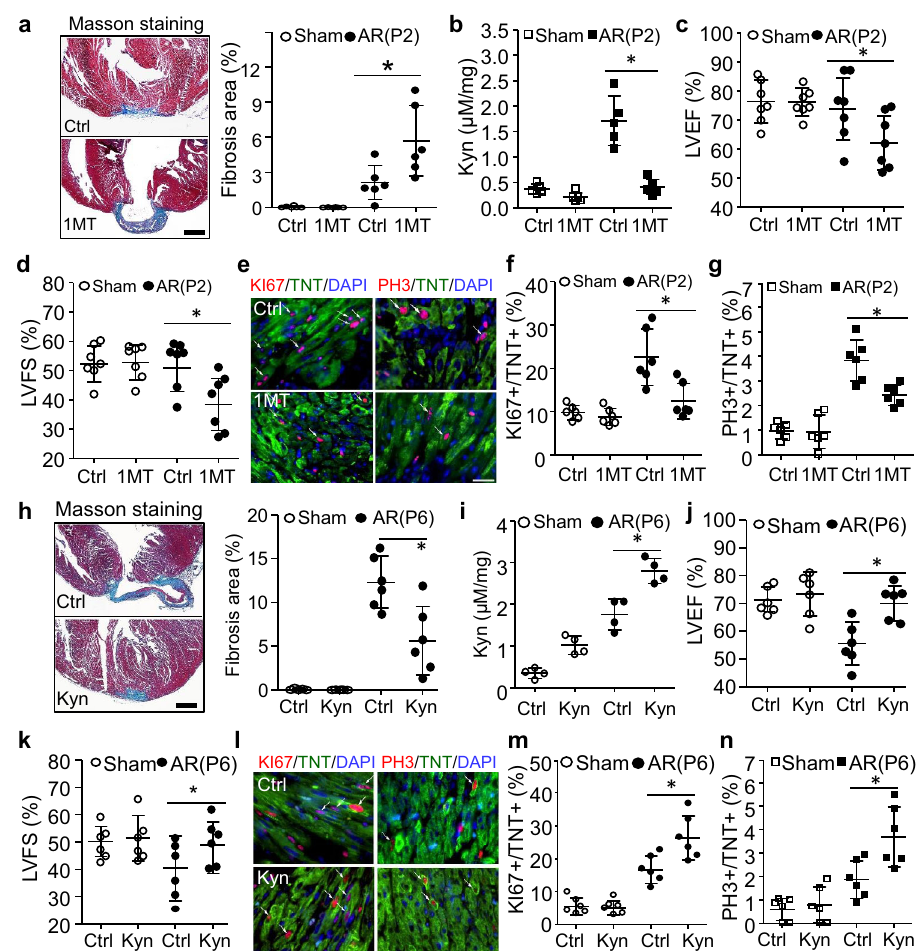
Fig. 2 | The effects of Kyn on neonatal heart regeneration. a – g Wild-type mice were intraperitoneally injected with IDO1 inhibitor (1-methyl tryptophan, 1MT, 100mg/kg)orPBS(Control,Ctrl)everyotherdayfromP1uptoP28andunderwent heart AR surgery at P2. Cardiac fi brosis, function, and Kyn concentration were analyzed at P28. a Masson staining was used for detection and quantitation of fi brosisarea( n =6/group,* P =0.0074). b CardiacKynconcentrationwasmeasured by HPLC ( n =5/group, * P <0.0001). c , d Left ventricular ejection fraction (LVEF, * P =0.0363) and left ventricular fraction section (LVFS, * P =0.0156) were deter- mined byechocardiogram ( n =7/group). e – g The cardiomyocyte proliferation was determinedandquanti fi edbyco-stainingofKI67(* P =0.0017)orPH3(* P =0.0031) with Troponin T (TNT) at P7 ( n =6/group). h – n Wild-type mice were